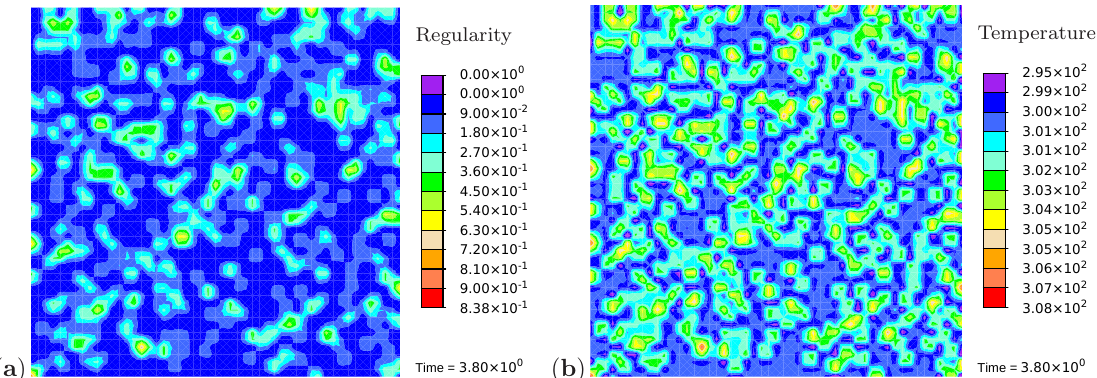
Figure 9. Cyclic tensile test with random initial microstructure. Snapshots of the microstructure evolution during the loading stage (¯ λ = 4.8) showing ( a ) regularity distribution and ( b ) temperature distribution (in